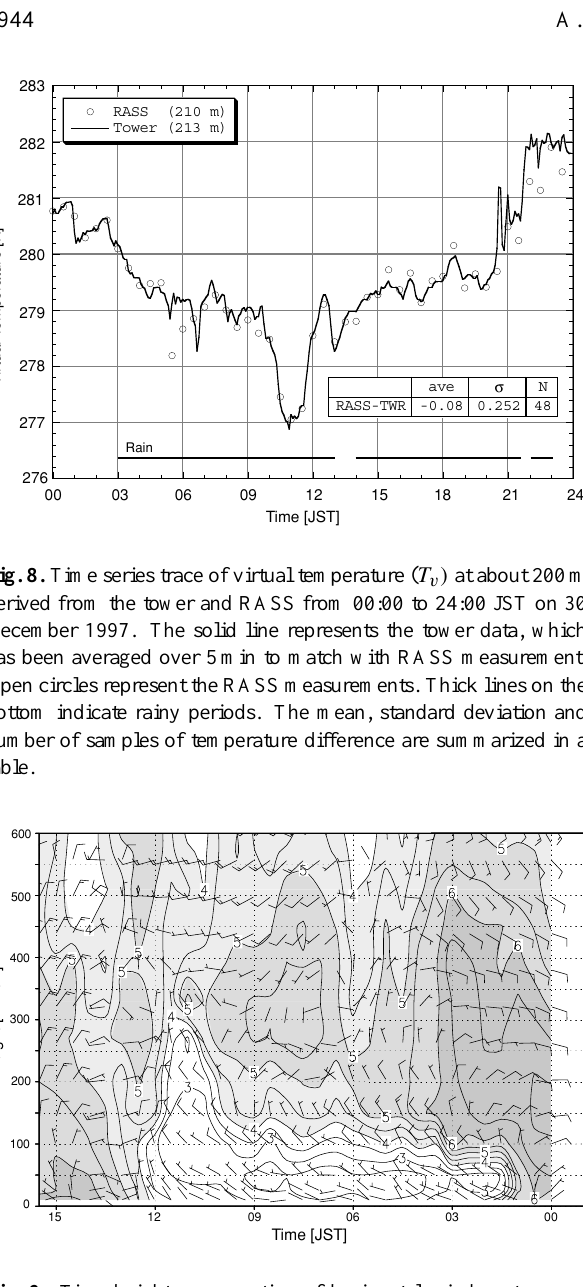
Fig. 9. Time-height cross section of horizontal wind vectors and temperature ( ◦ C) from 00:00 to 15:30 JST on 30 December 1997. Time runs from right to left, a full wind barb is 5 m s − 1 , and the contours with gray scale represent temperature with a contour interval of 0.5 ◦ C. The data through 200m altitude are from the tower, whereas higher observations are derived from the wind pro- filer/RASS. The profiler data have been shifted in time so that the gravity current is coincident in the two data sets.